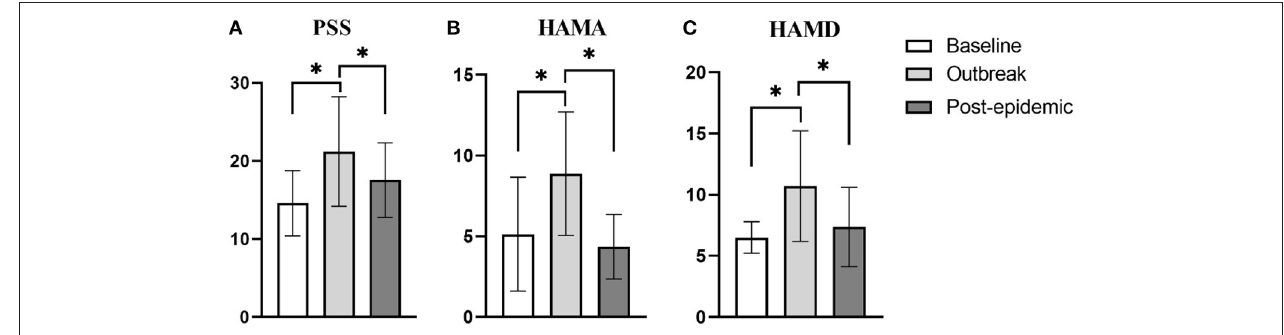
FIGURE 1 | Differences in the score of PSS, HAMA, and HAMD in the three periods. (A) The difference in the score of PSS. When the outbreak, the score of PSS was significantly higher than the baseline and post-epidemic ( p < 0.01, p = 0.02, respectively). (B) The difference in the score of HAMA. When the outbreak, the score of HAMA was significantly higher than the baseline and post-epidemic ( p < 0.01, p < 0.01, respectively). (C) The difference in the score of HAMD. When the outbreak, the score of HAMD was significantly higher than the baseline and post-epidemic ( p < 0.01, p < 0.01, respectively). * p <